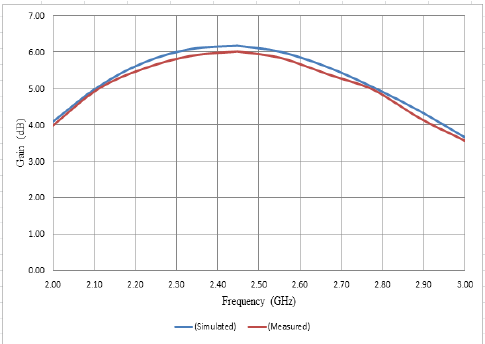
Figure 6. Simulated and measured Gain Vs Freq.